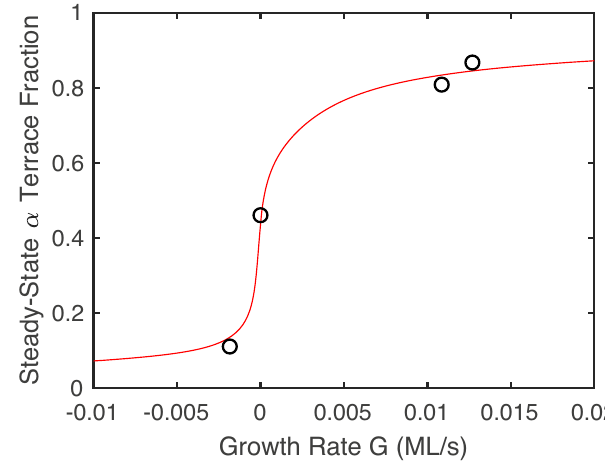
Fig. 8 Steady state α terrace fraction f ss α as a function of growth rate G . Circles are experimental values given in Table 1, showing monotonic increase of f ss α with increasing G . Curve is best- fi t BCF model calculation; also fi t simultaneously with these four points were the two relaxation times t rel given in Table 1. c = 5.20 × 10 − 10 m are the lattice parameters of GaN at the growth f ss α and two t rel ) using the general expressions for K ss ( f α ) and K dyn